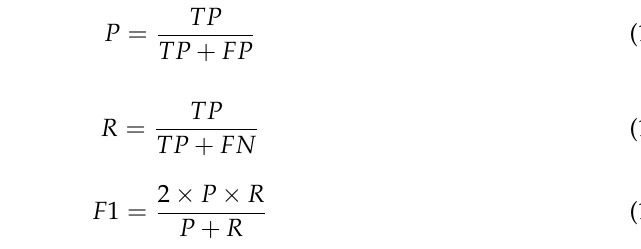
Table 3. Confusion matrix. Real Positive Value Real Negative Value Predicted Positive Value TP FP Predicted Negative Value FN